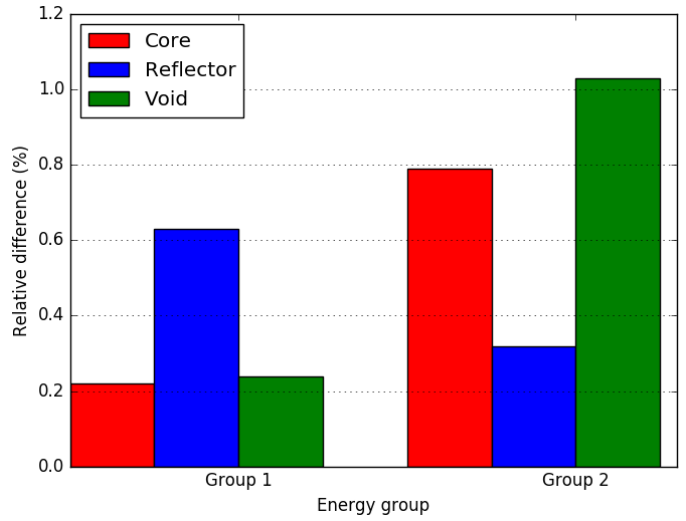
Figure 7. Comparison of region-averaged flux from reference and Parafish Model 1 Case 1.